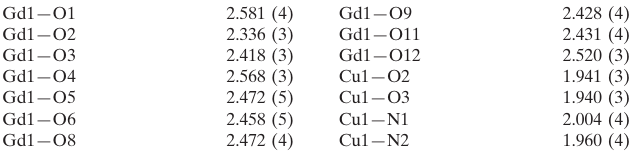
Selected bond lengths (A˚